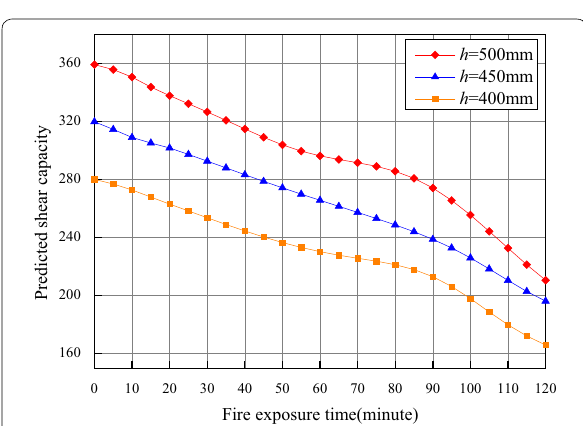
Fig. 9 Effect of beam height h on shear resistance of beams.